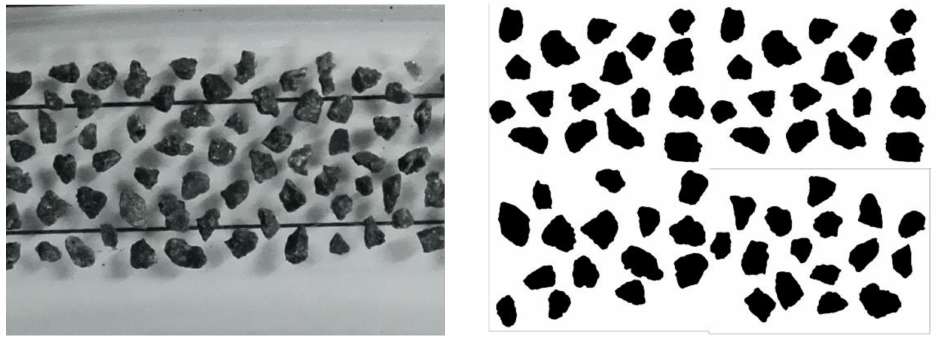
Figure 2. Visualized fine aggregates (left) and Aggregate Image Measure System (AIMS) image (right).